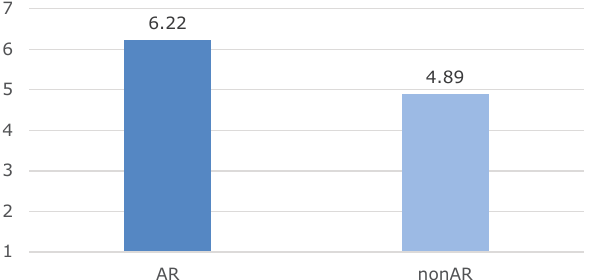
Figure 6. Mean values of usefulness of each visualization mode for interior design at home. Standard deviation is 0.97 for AR and 1.59 for non-AR visualization.